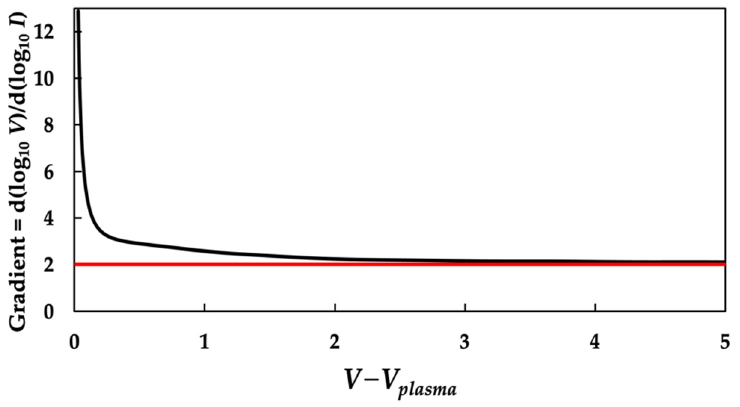
Figure 6. Pilling and Carnegie curve of zone I of an experimental IVCP for the same discharge conditions as those in Figure 4.